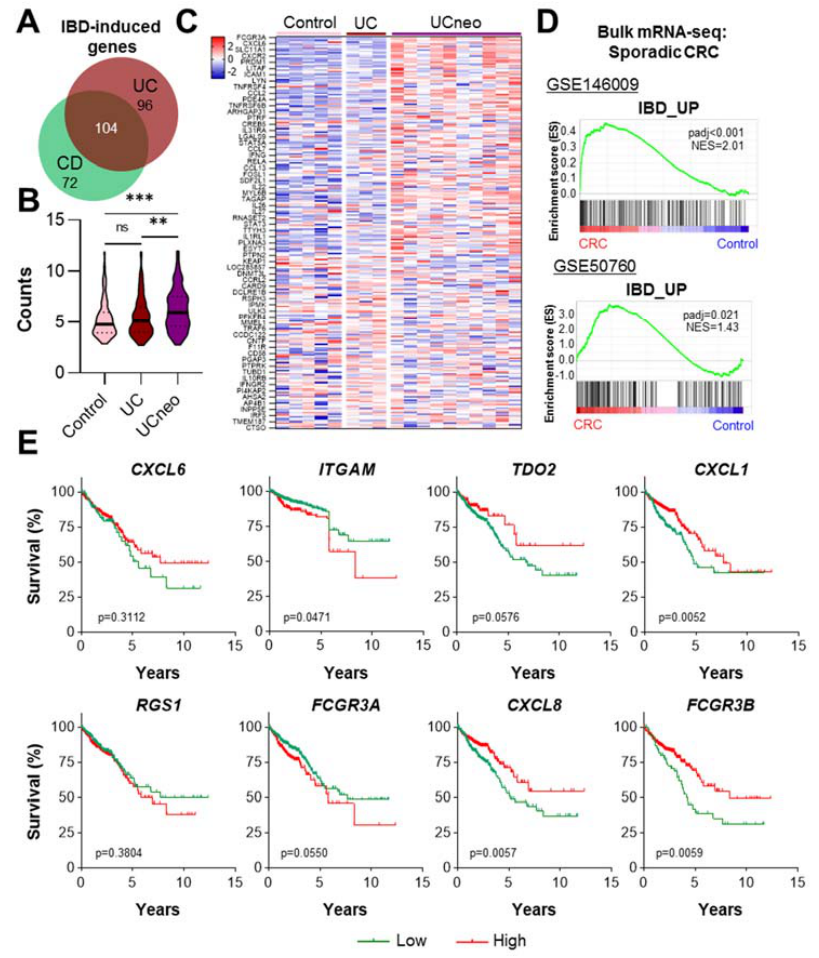
Figure 3. Enrichment of CD risk genes in UC ‐ associated neoplasia and sporadic CRC. ( A )